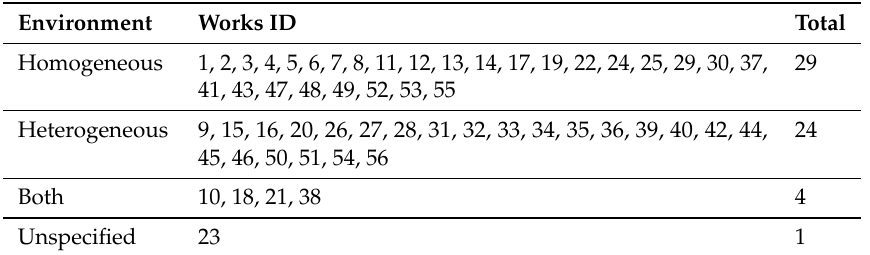
Table 4. Computational